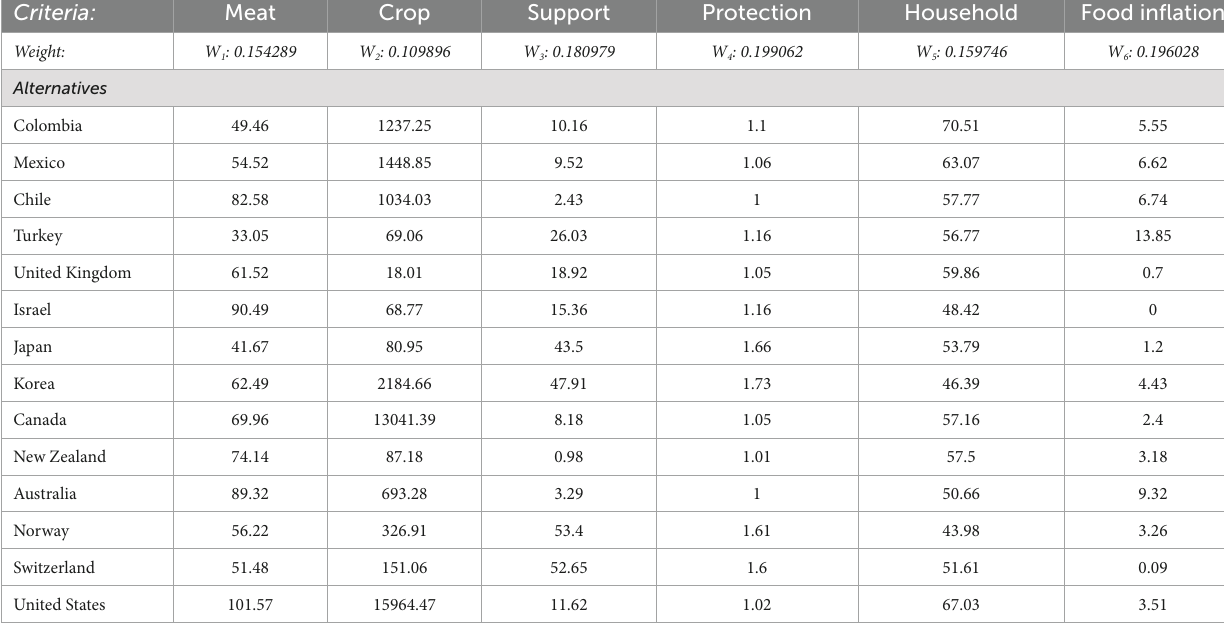
TABLE 5 Unweighted matrix and criteria weights. Criteria: Meat Crop Support Protection Household Food inflation